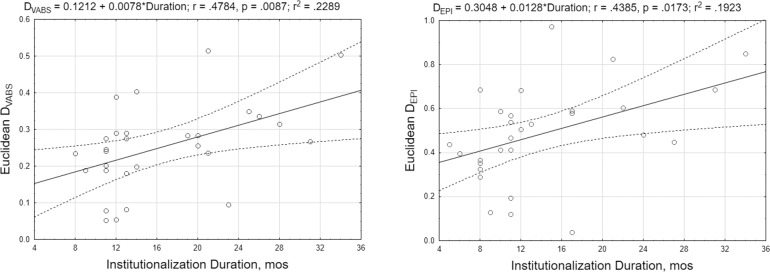
Scatterplots representing the associations between the duration of institutionalization and the distance (Euclidean D in the range from 0 to 1) of IC children's behavioral profiles (DVABS ; left plot) and DNA methylation profiles (DEPI; right plot) from the average profile in the BFC group.